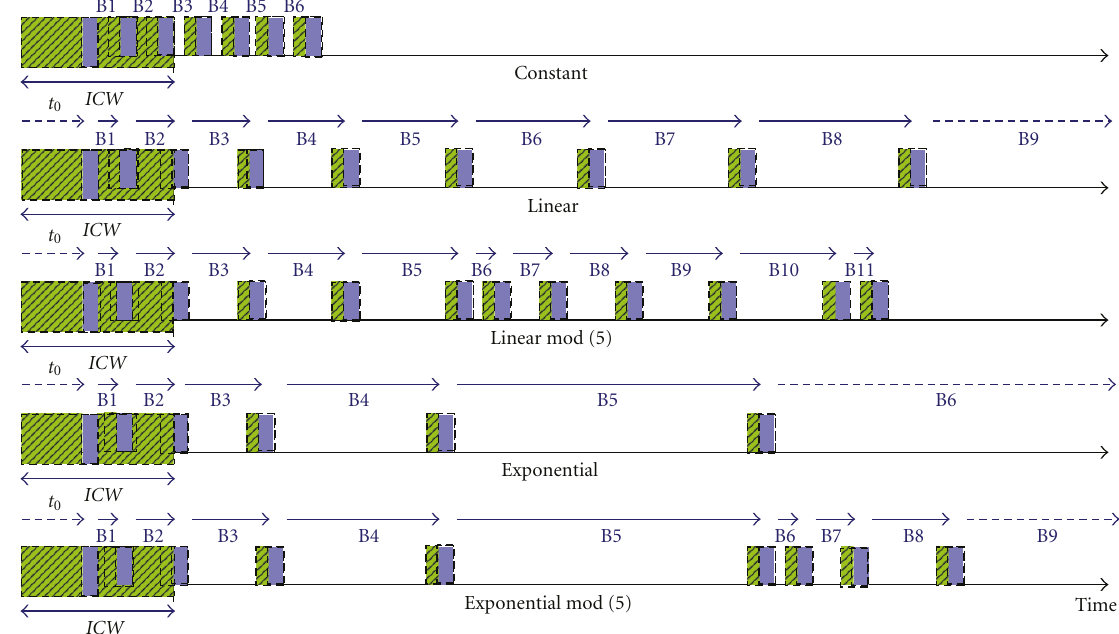
Figure 8: Types of back-o ff algorithms: constant, linear, linear modulus, exponential, and exponential modulus. The arrow ending at time t o (randomly chosen by each tag in the range of the ICW ) is the initial back-o ff , then increasing B-numbers show successive back-o ff s. Shadowed parts show randomness in the back-o ff time which is added to each T i .